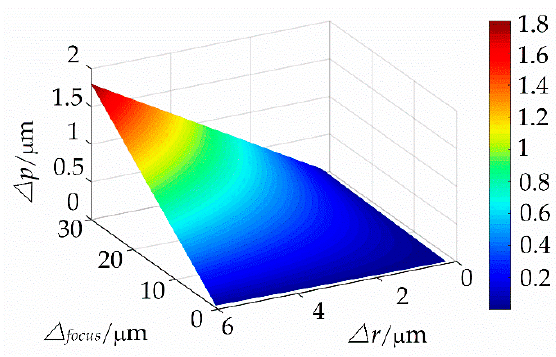
Figure 12. Relationship between the focal plane deviation and offset deviation of the lithography pitch.